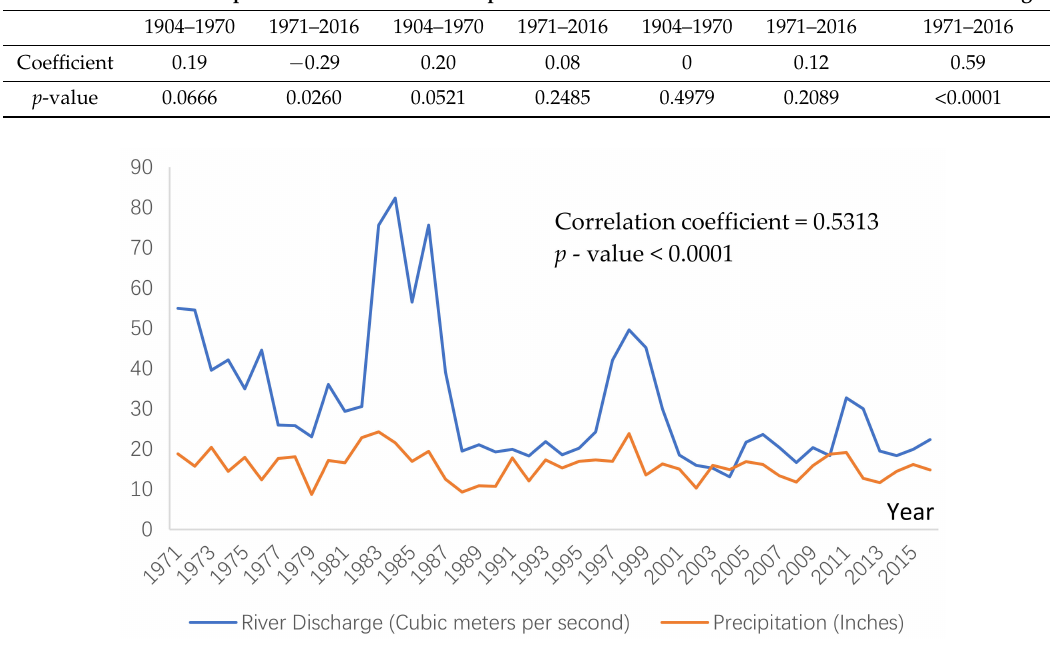
Table 2. Correlation between temperature, precipitation, snowfall, river discharge, and GSL water level. Temperature Precipitation Snowfall